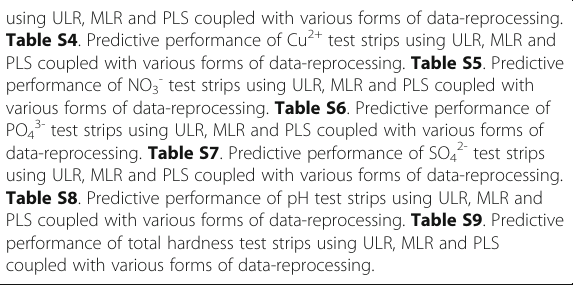
Table S8 . Predictive performance of pH test strips using ULR, MLR and PLS coupled with various forms of data-reprocessing. Table S9 . Predictive performance of total hardness test strips using ULR, MLR and PLS coupled with various forms of